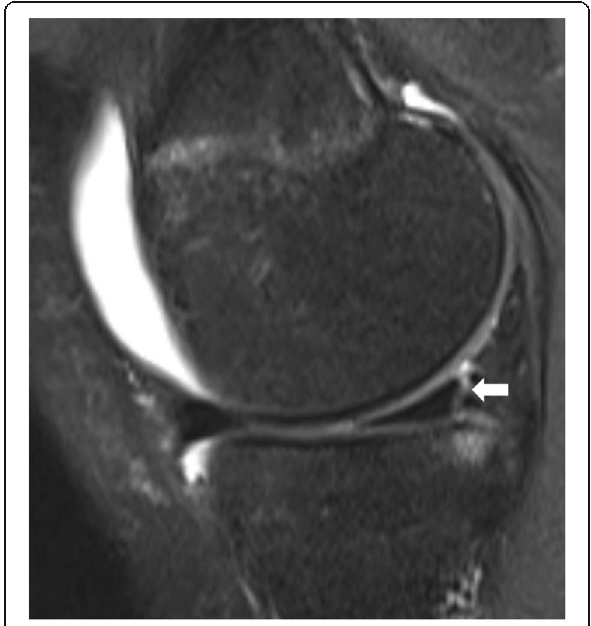
Fig. 3 A ramp lesion on a sagittal magnetic resonance imaging exam (MRI). The white arrow points to a peripheral tear in the posterior horn of the medial meniscus, aka a ramp lesion. These lesions are often missed on MRI, and even during